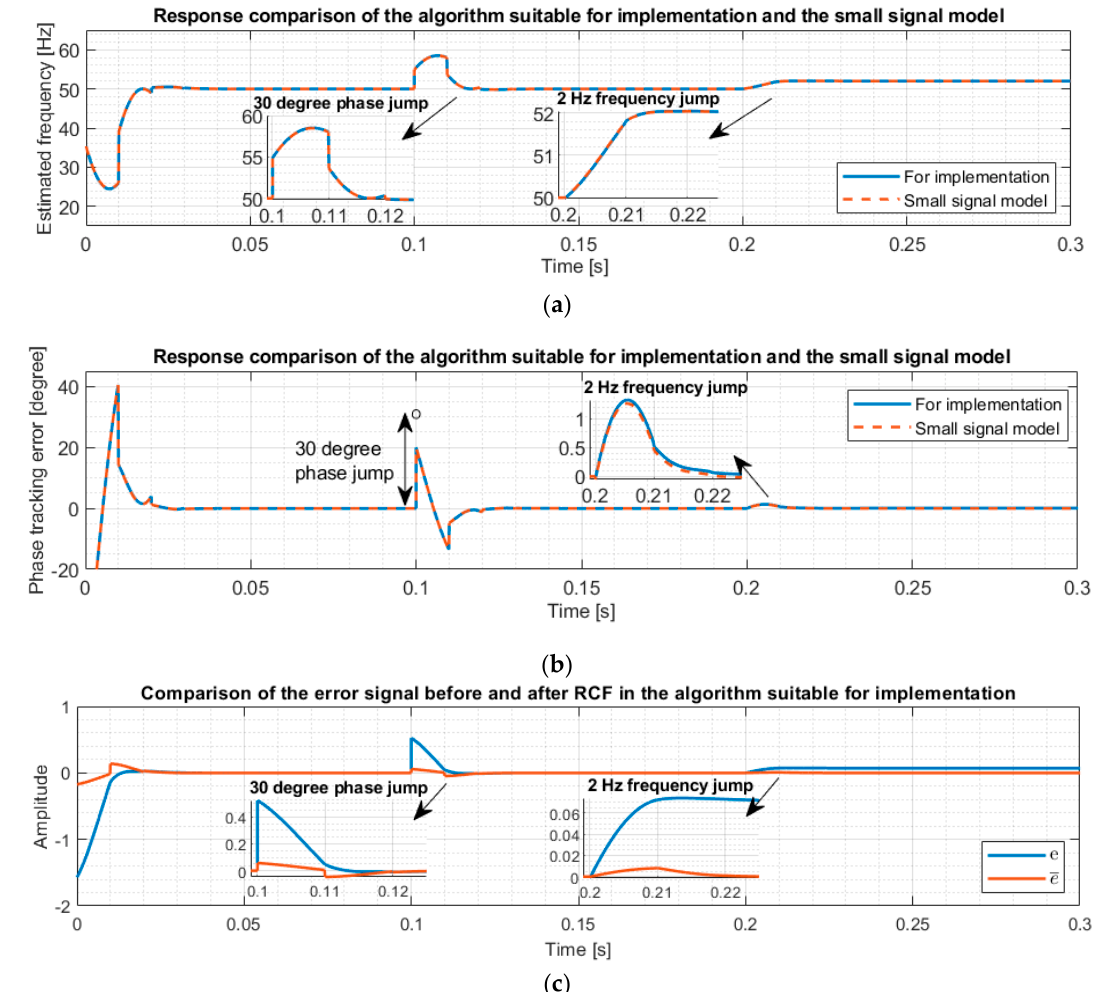
Figure 6. Dynamic behavior of RCE-PLL and its small-signal model. ( a ) Estimated frequency; ( b ) fundamental grid voltage vector phase angle error; ( c ) error signal before and after the RCF.